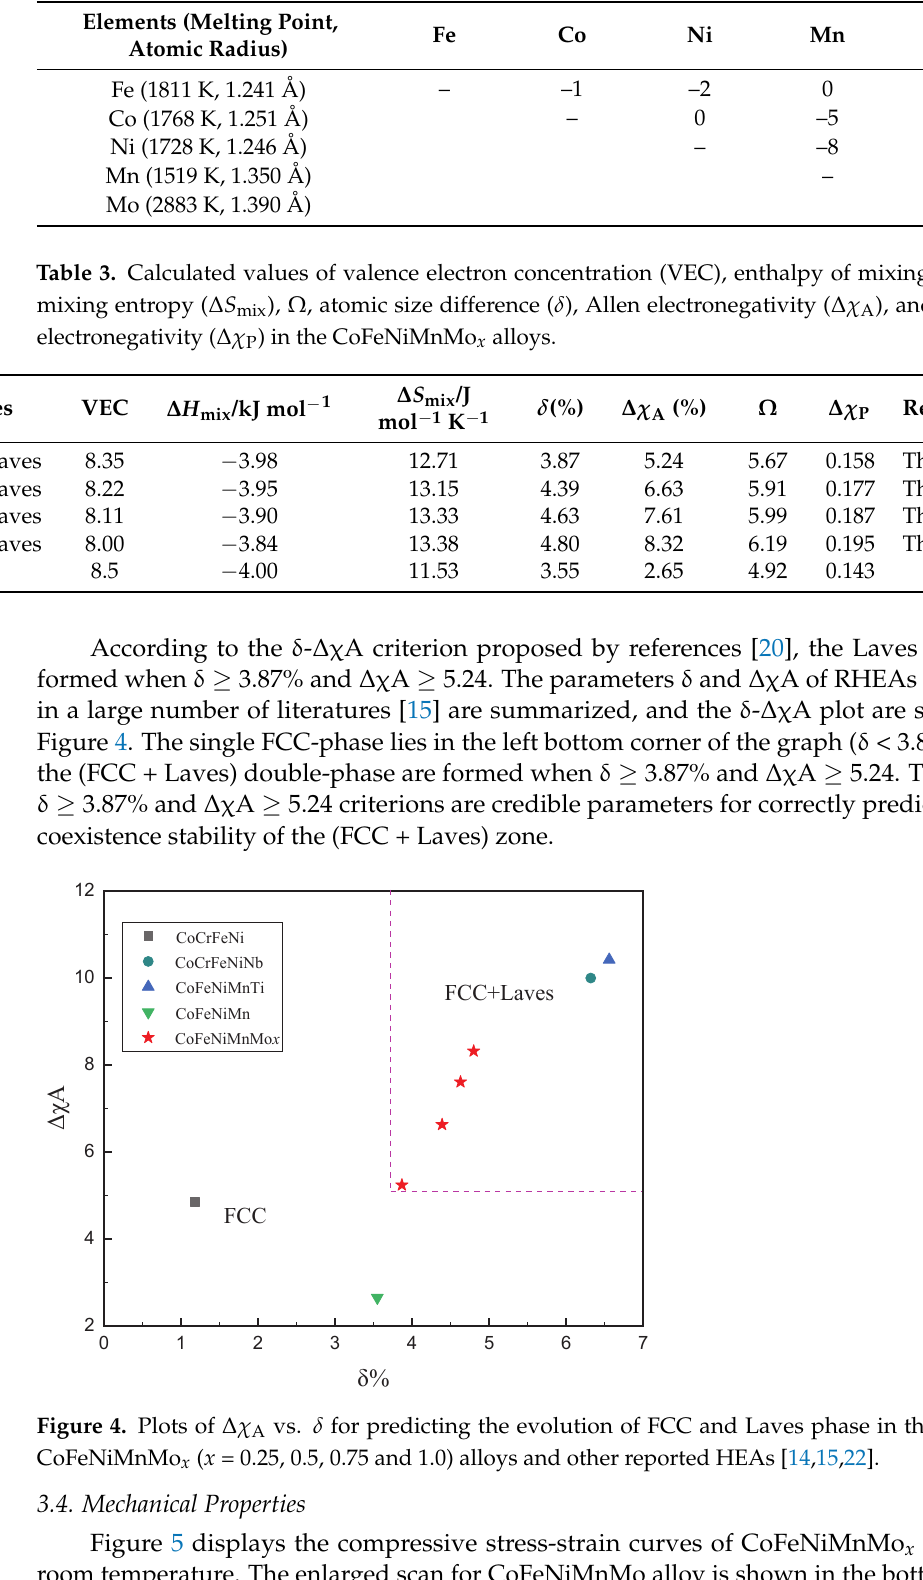
Table 2. Enthalpy of mixing (Unit: kJ/mol) of different atom pairs in the CoFeNiMnMo x alloys.